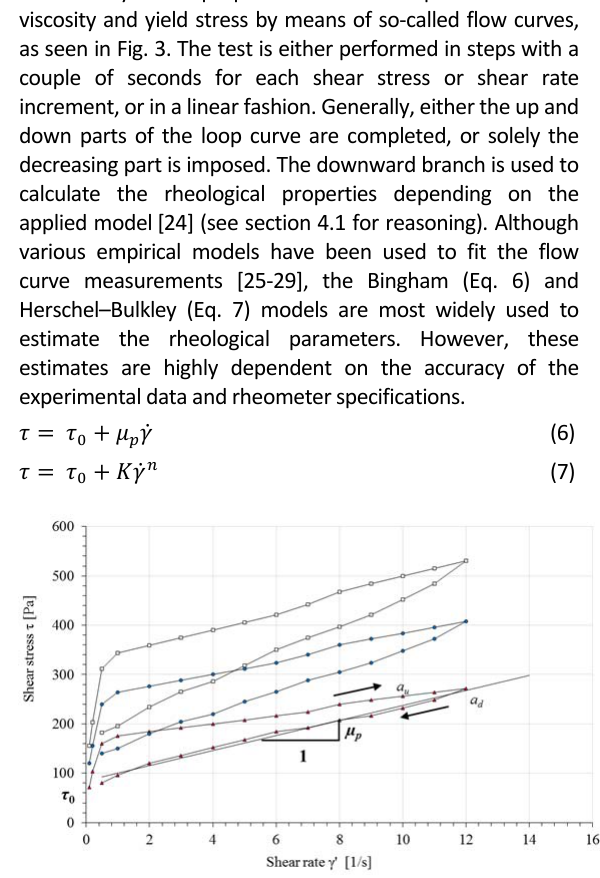
Figure 3 . Shear stress versus shear rate hysteresis cycles at different material age showing the ascending a u and descending a d branches and a linear approximation of the descending branch to determine the Bingham parameters yield stress τ 0 and plastic viscosity μ p